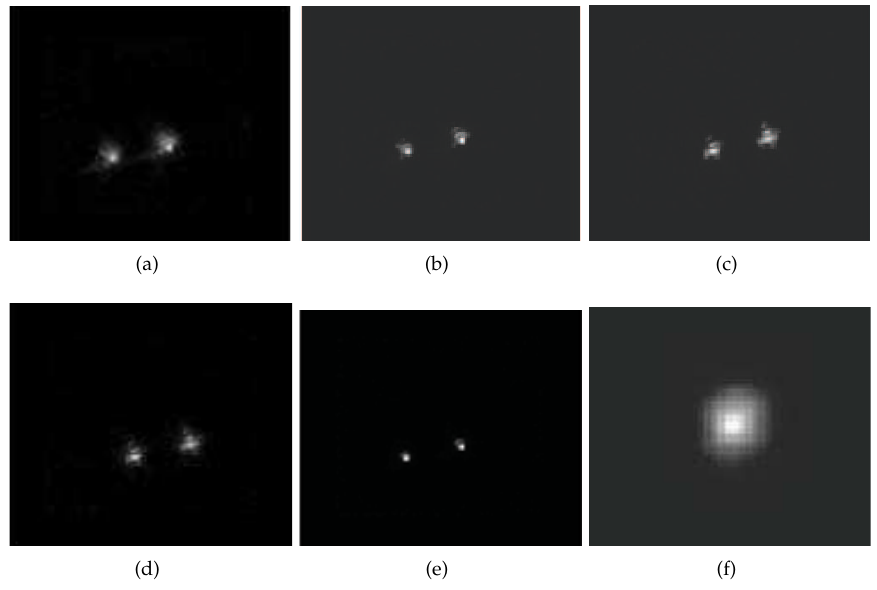
Figure 4. The restoration results comparison on multi-frames binary-star AO images. ( a ) restored image by the ML-EM algorithm; ( b ) restored image by the CPF-adaptive algorithm; ( c ) restored image by the RT-IEM algorithm; ( d ) restored image by the VBBD-TV algorithm; ( e ) restored image by our algorithm; ( f ) estimated PSF by our algorithm.